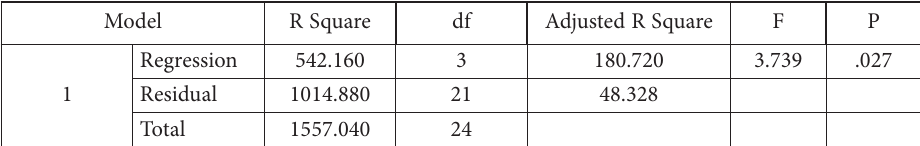
Table 3. ANOVA Regression